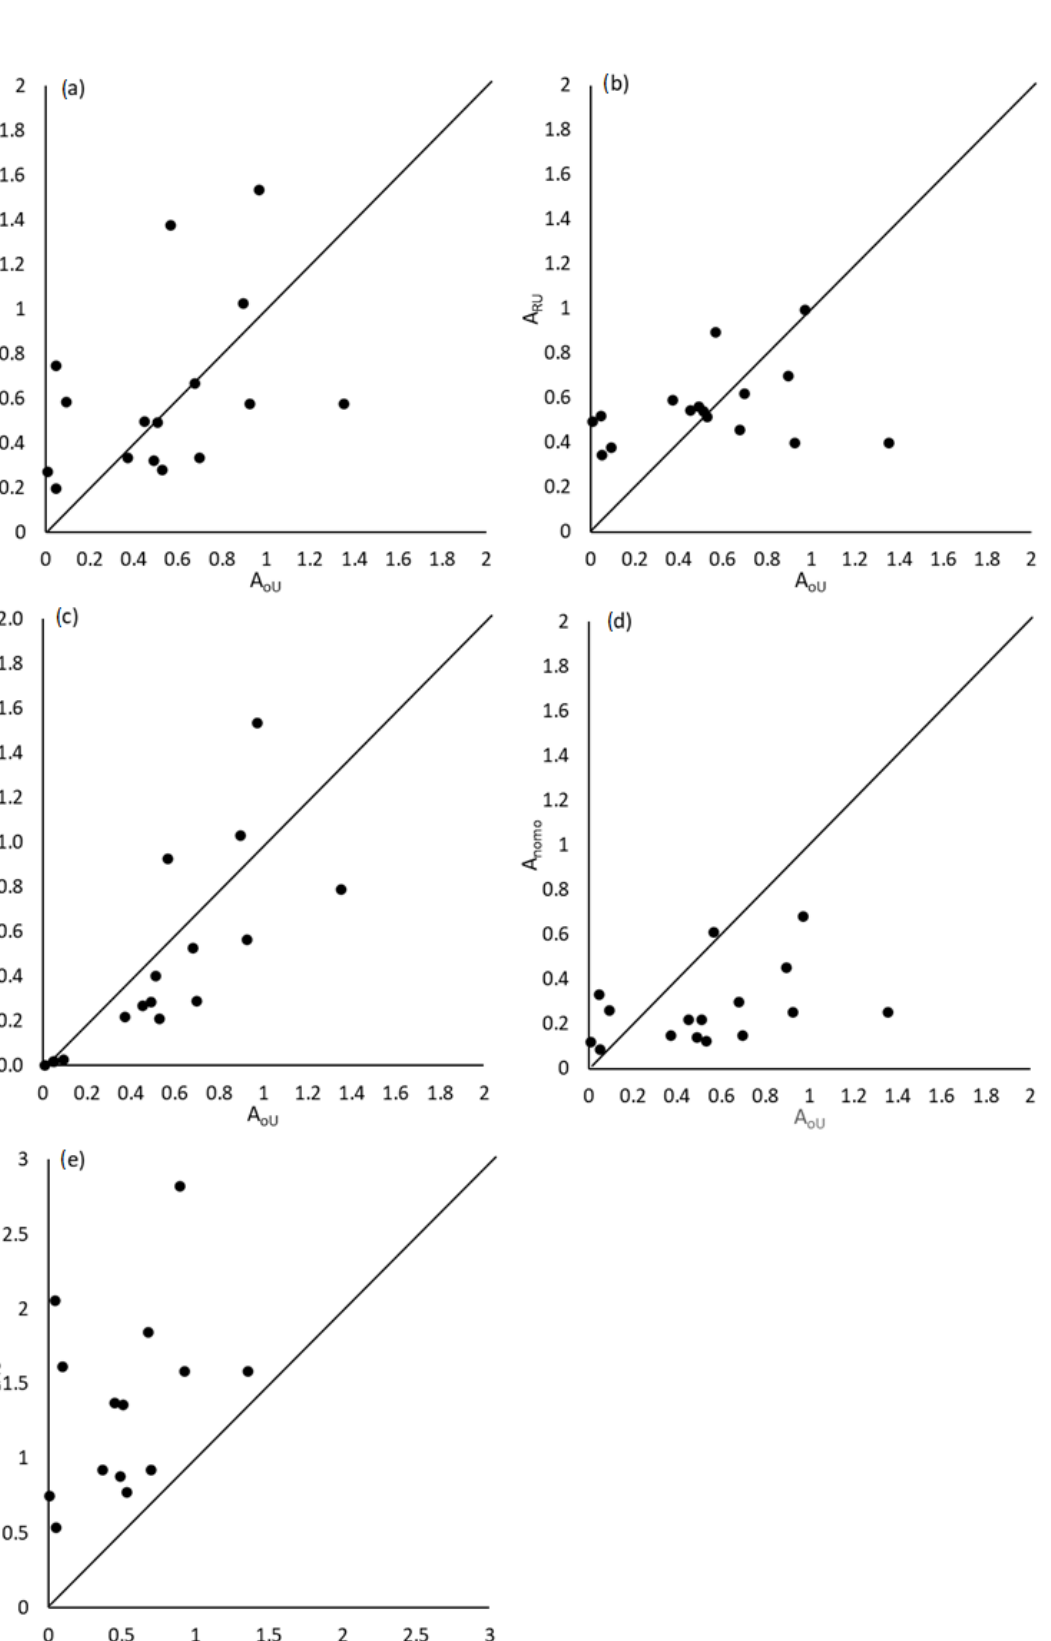
Figure 4. Comparison between the measured event soil loss values and the predicted ones by ( a ) USLE ( b ) RUSLE, ( c ) USLE-M, ( d ) USLE nomograph equation and ( e ) EPIC nomograph equation.